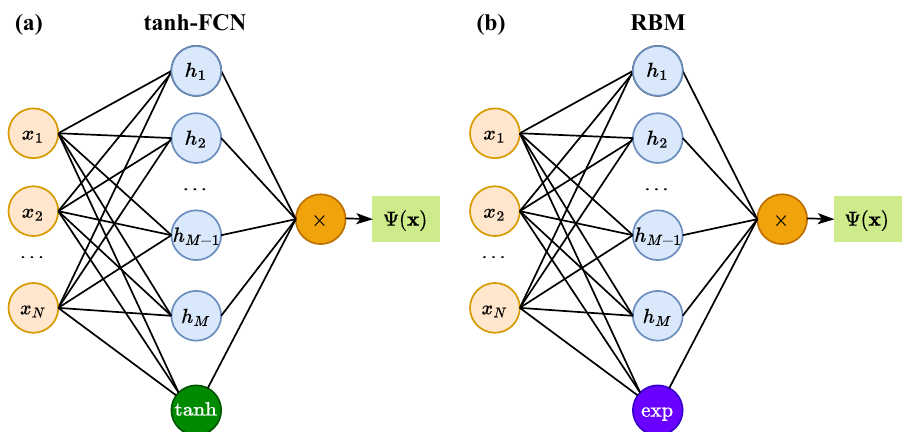
Figure 1. The architectures for ( a ) our tanh-FCN and ( b ) RBM. The major difference is that we use hyperbolic tangent as the activation function such that tanh-FCN could output both positive and negative numbers even if it only uses real